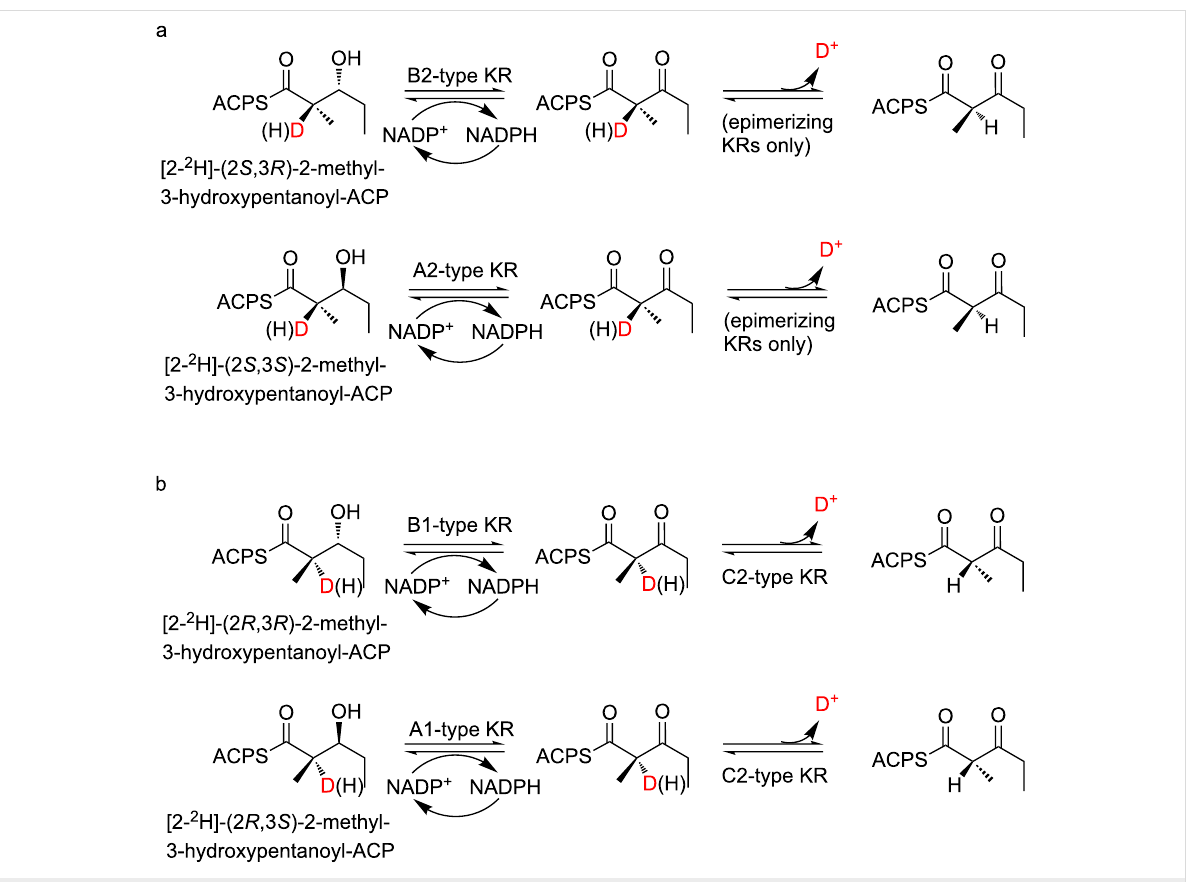
Figure 14: Assays in vitro to demonstrate directly the epimerase activity of PKS KR domains. a) Equilibrium exchange assay [86]. In these assays, an equilibrium is established between stereospecifically deuterated 3-hydroxy diketide-ACP (incorporating either (3 R )- or (3 S )-hydroxy stereochemistry as appropriate) and the 3-keto form, which then undergoes KR-catalyzed racemization at the C-2 center. This epimerizing activity is detected by LC–MS via time-dependent washout of deuterium from the reduced product. While A1 or B1-type KRs could catalyze the oxidation of the deuterated compounds, the deuterium would not be lost by subsequent epimerization. b) Tandem equilibrium exchange assay [87]. The aim of this assay is to demonstrate the intrinsic epimerization activity of non-reducing KRs (C2-type). As these are not capable of establishing the initial equilibrium between the C-3 hydroxy and keto forms of the substrate, an additional reducing but non-epimerizing KR (either A1- or B1-type) is added to the assays to carry out these step with (3 R )- and (3 S )-hydroxy substrates, respectively. The epimerizing capacity of the KR under study is then detected as for the clas- sical equilibrium exchange assay described